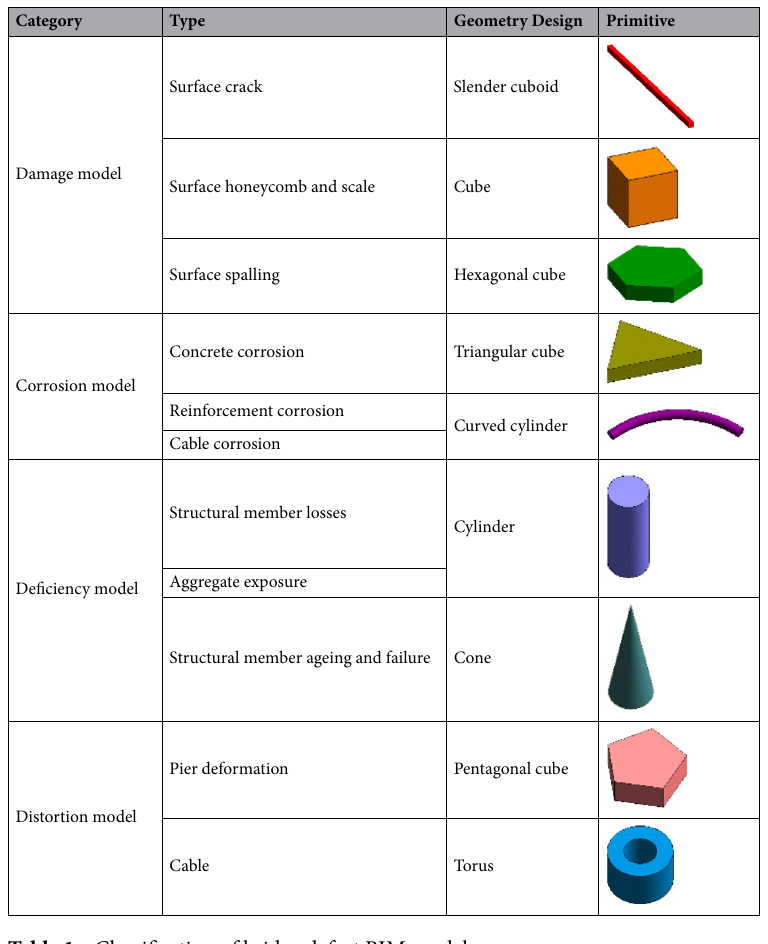
Table 1. Classification of bridge defect BIM models.